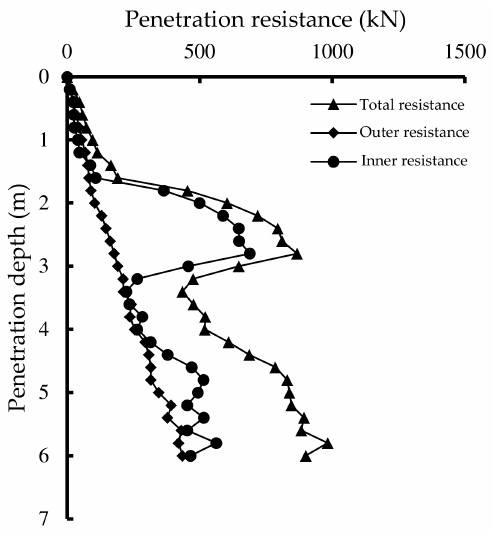
Figure 11. Penetration resistance curve for condition a